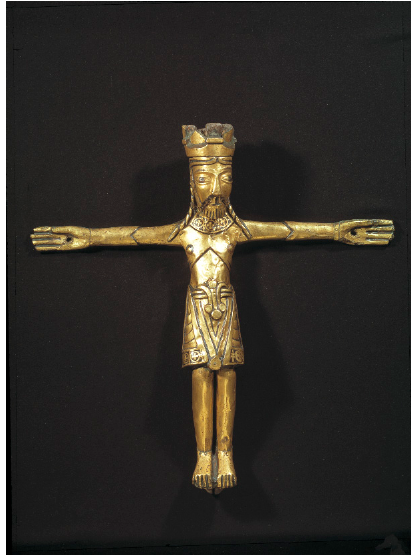
Figure 9. Crucifix from Åby. Gilded silver on wood, c .1100. Copenhagen, National Museum of Denmark, Inv. No. D629. Photo: Lennart Larsen (CC BY SA).